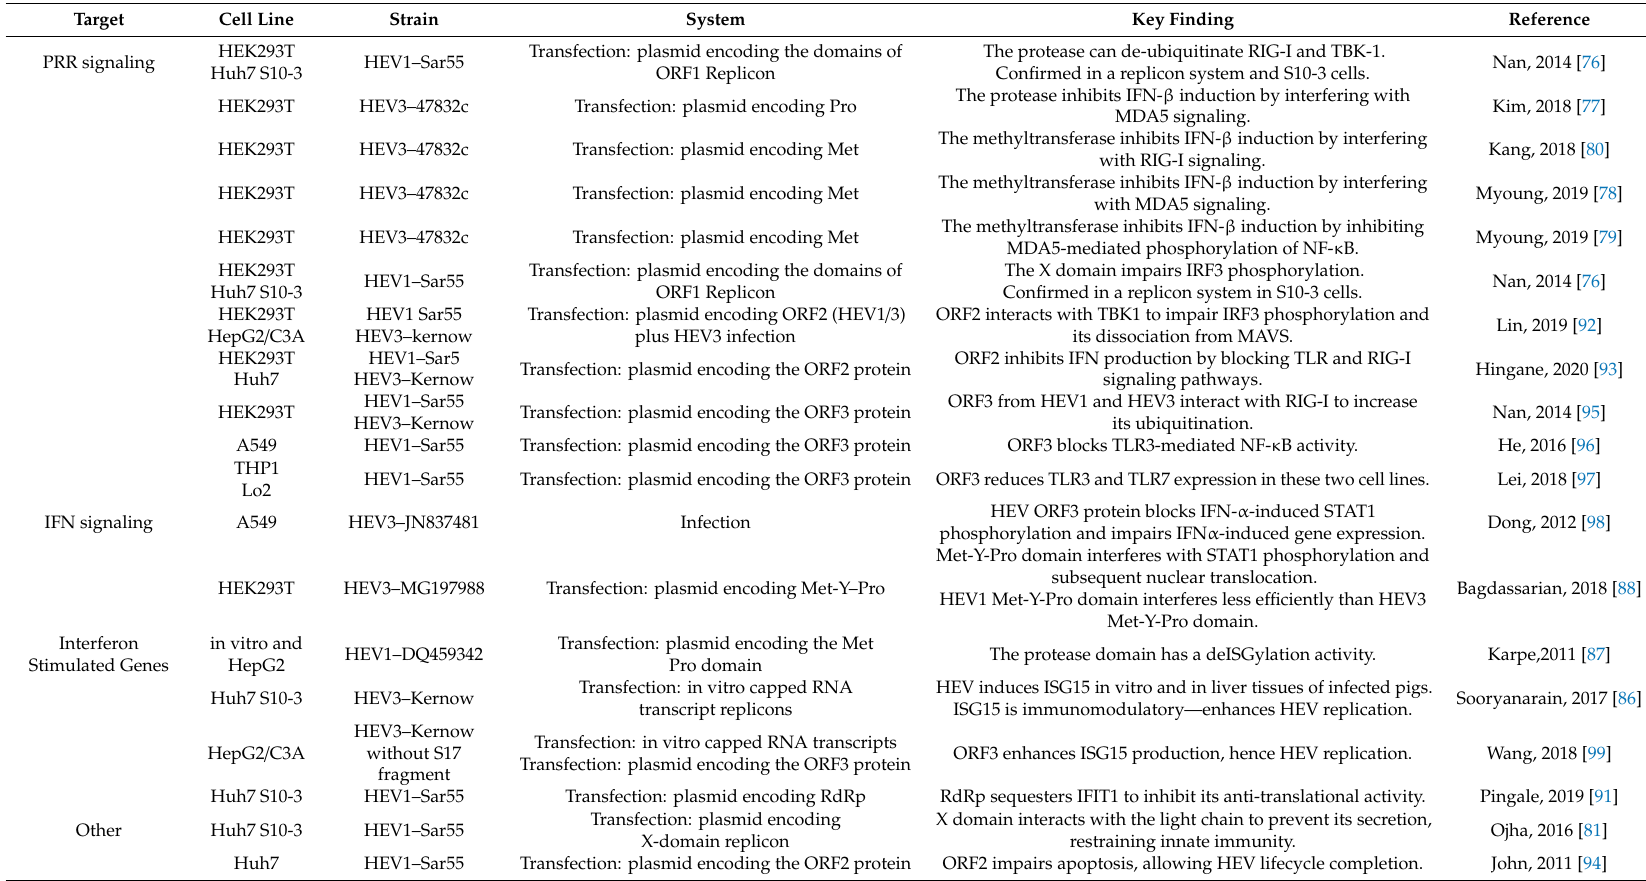
Table 1. The main mechanisms of HEV